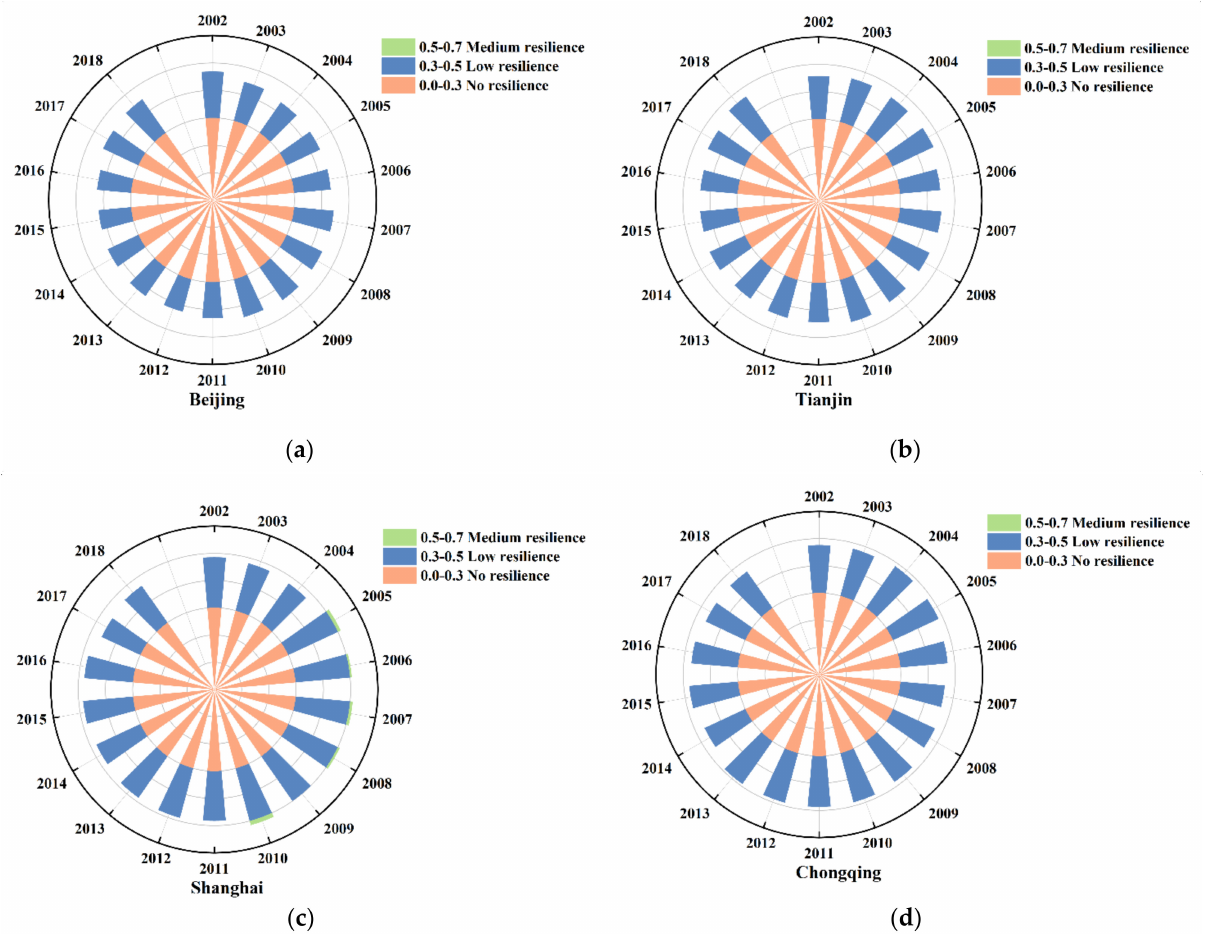
Figure 6. The trends of urban infrastructure resilience levels from 2002 to 2018. ( a ) Beijing; ( b ) Tianjin; ( c ) Shanghai; ( d )